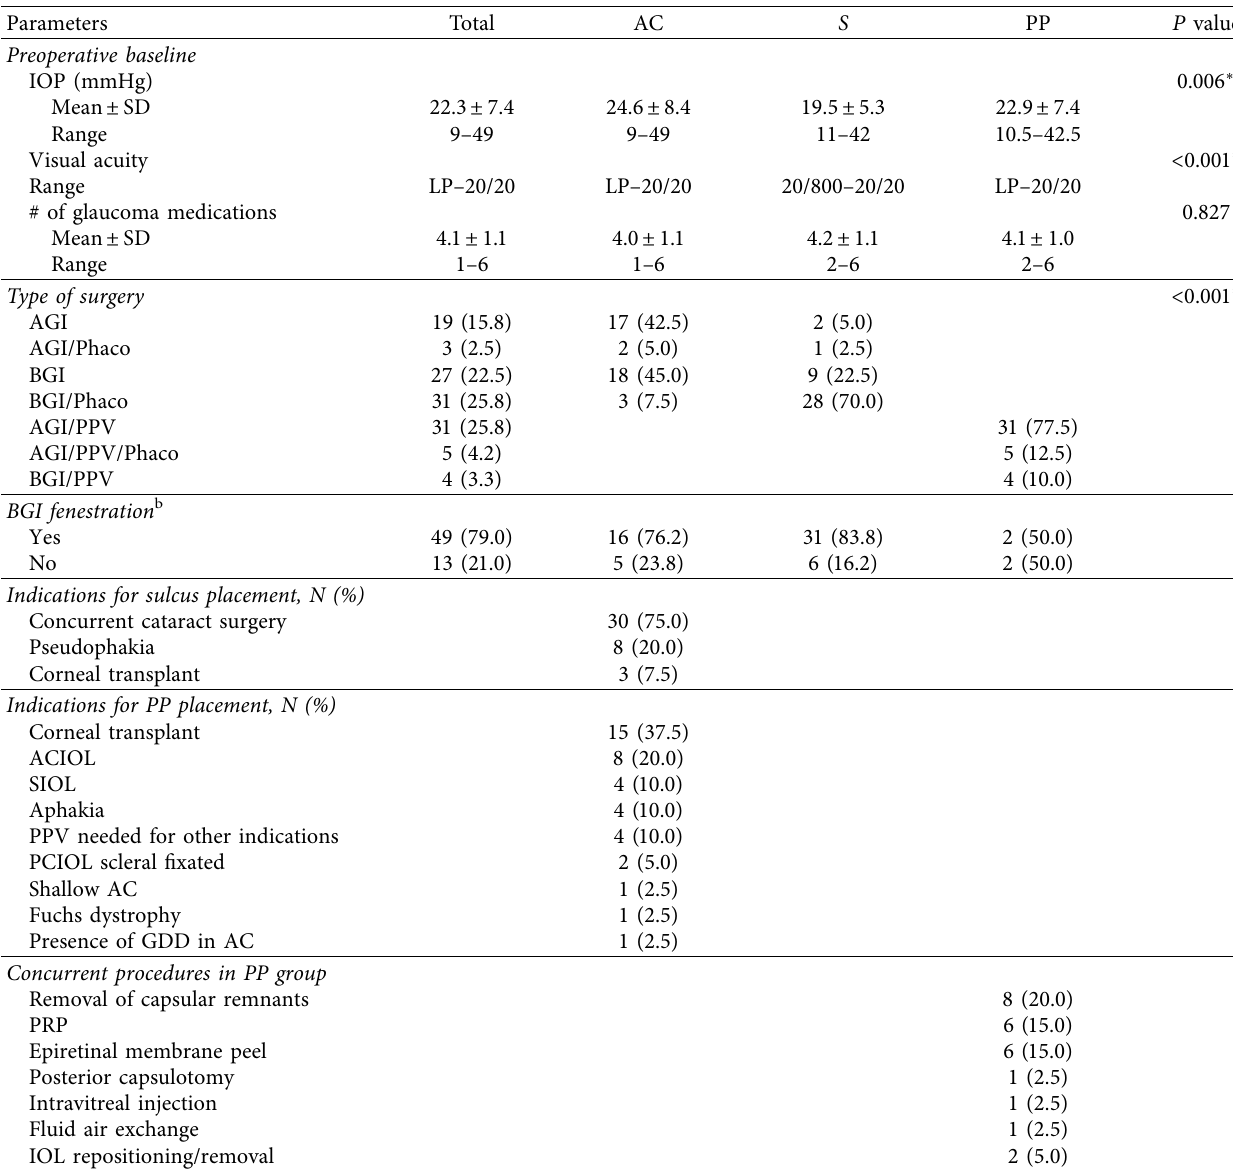
Table 2: Preoperative and surgical data a